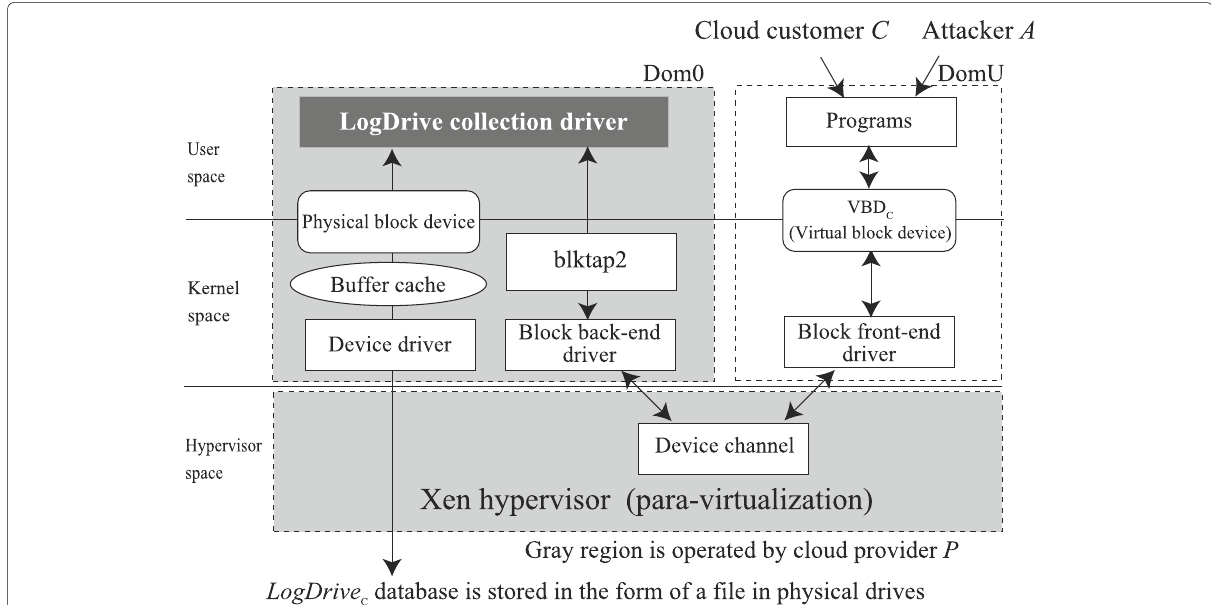
Fig. 6 Implementation of the proactive data collection function